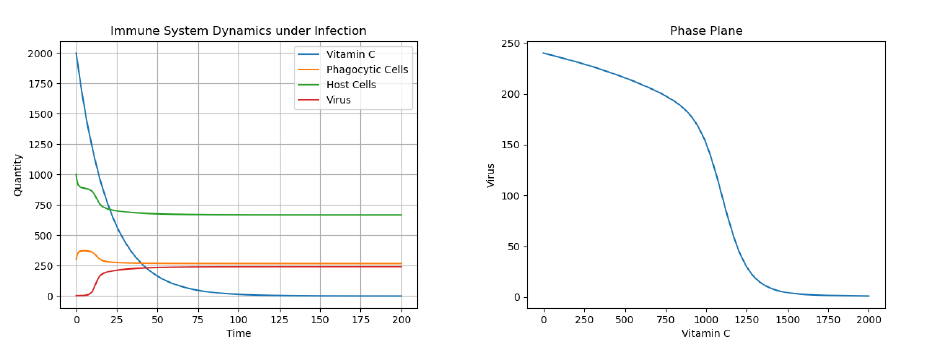
Figure 4. Dynamics with 1 Initial Virus Present with Single Vitamin C Dose